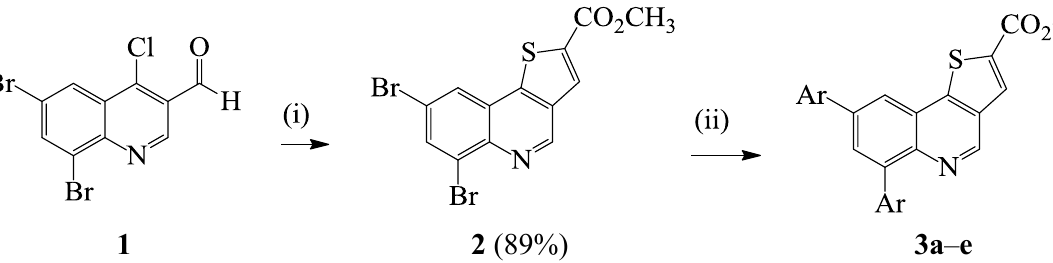
Reagents and conditions : (i) HSCH 2 CO 2 Me (2.5 equiv.), K 2 CO 3 , CH 3 CN, reflux, 3 h; (ii) ArB(OH) 2 (2.5 equiv.),